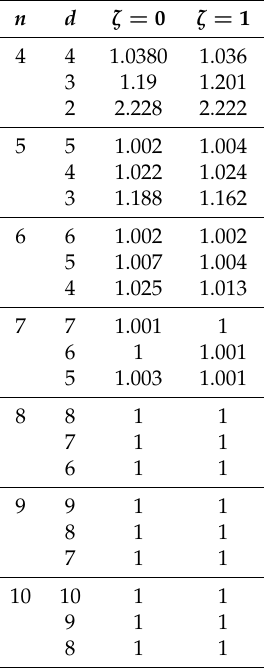
Table 1. Average value of iterations in Algorithm